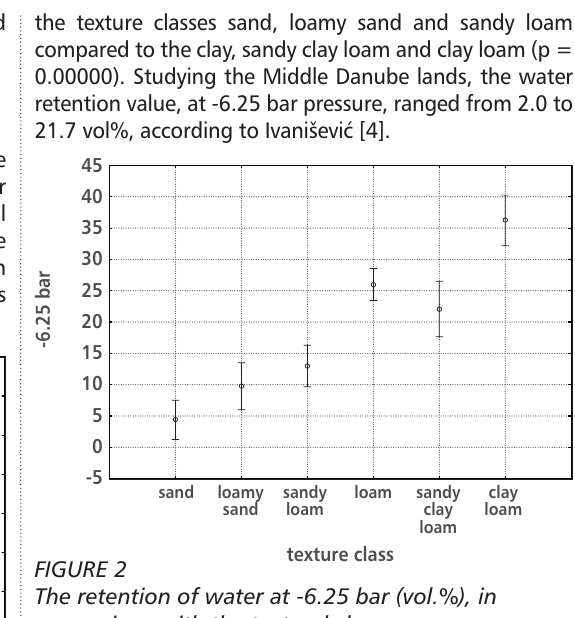
The retention of water at -6.25 bar (vol.%), in comparison with the textural class